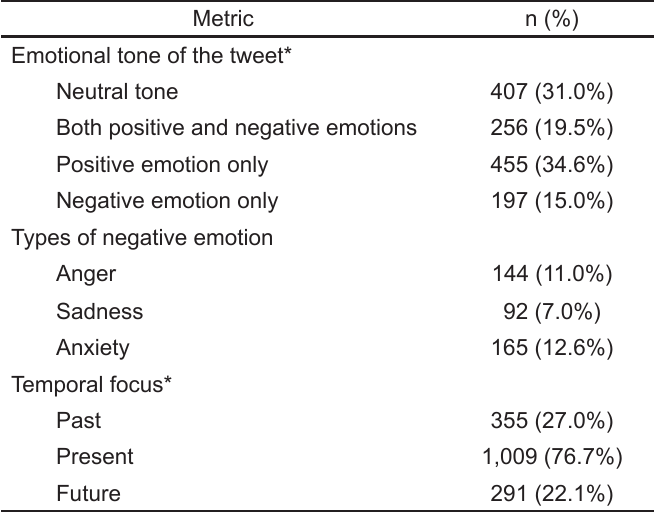
Table 3. Describing the language of the tweets (N = 1,315).